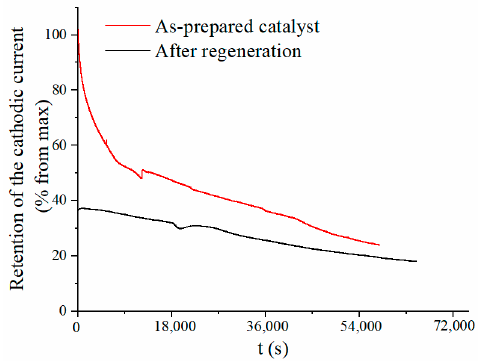
Figure 6. Stability of the Pt / Cu (PC) catalyst in O 2 -saturated 0.2 M NaOH electrolyte in potentiostatic mode at 0.7 V (vs. RHE) and 1000 rpm.